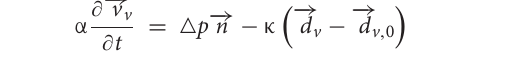
equation of motion (Equation 2), shown below: